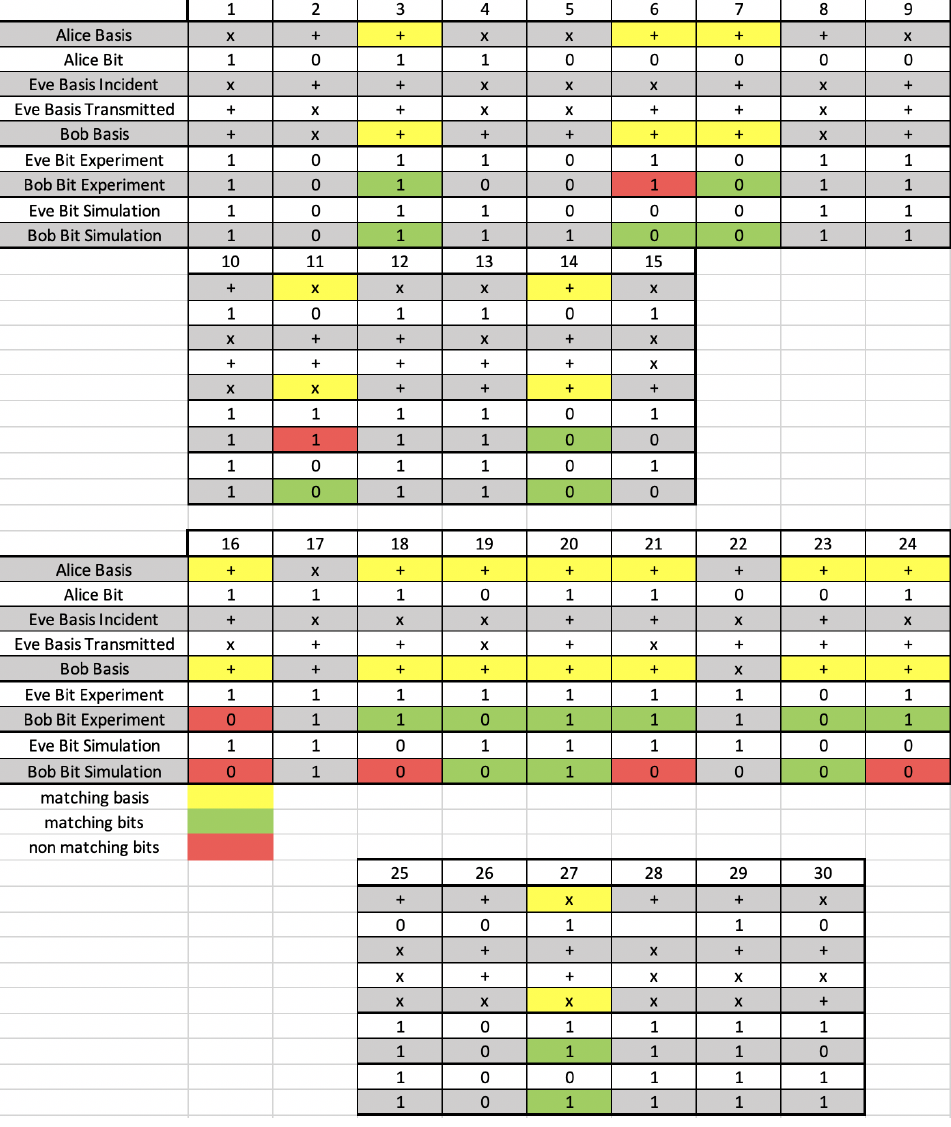
Figure A5. 30 bit transmission results from Alice to Bob with Eve—experiment and